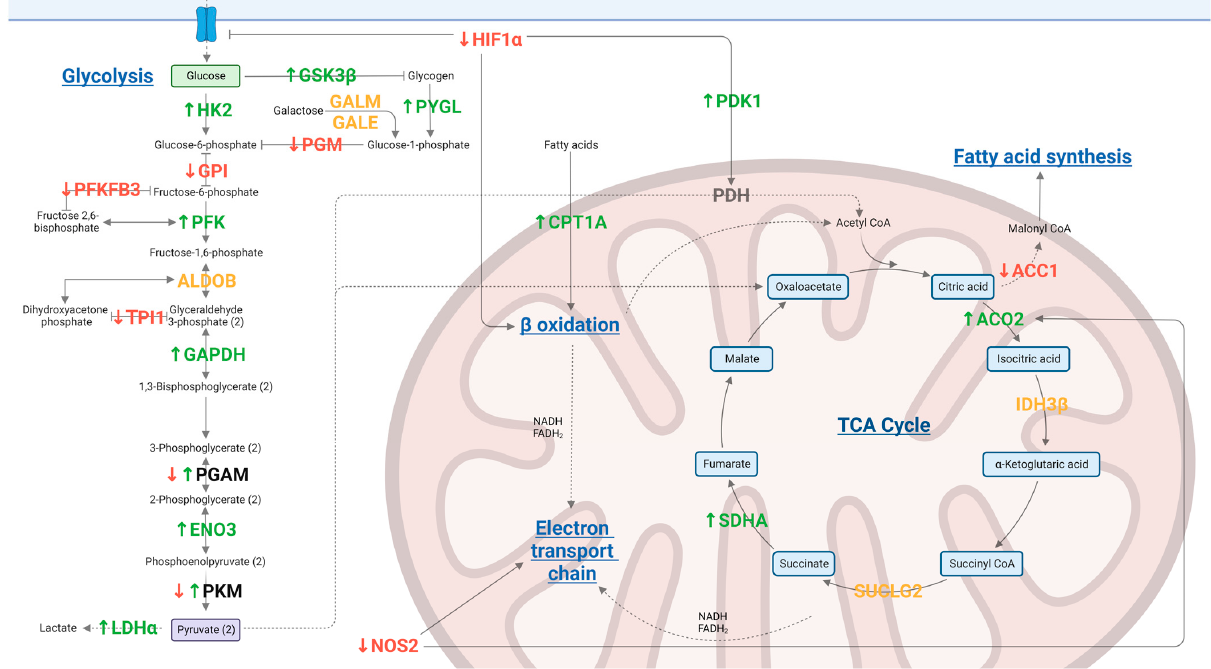
Figure 1. Summary of the main phosphorylation changes of significant metabolic peptides ( p ≤ 0.05) of HD11 cells infected with S. Enteritidis and treated with gentamicin. ↑ protein, significantly